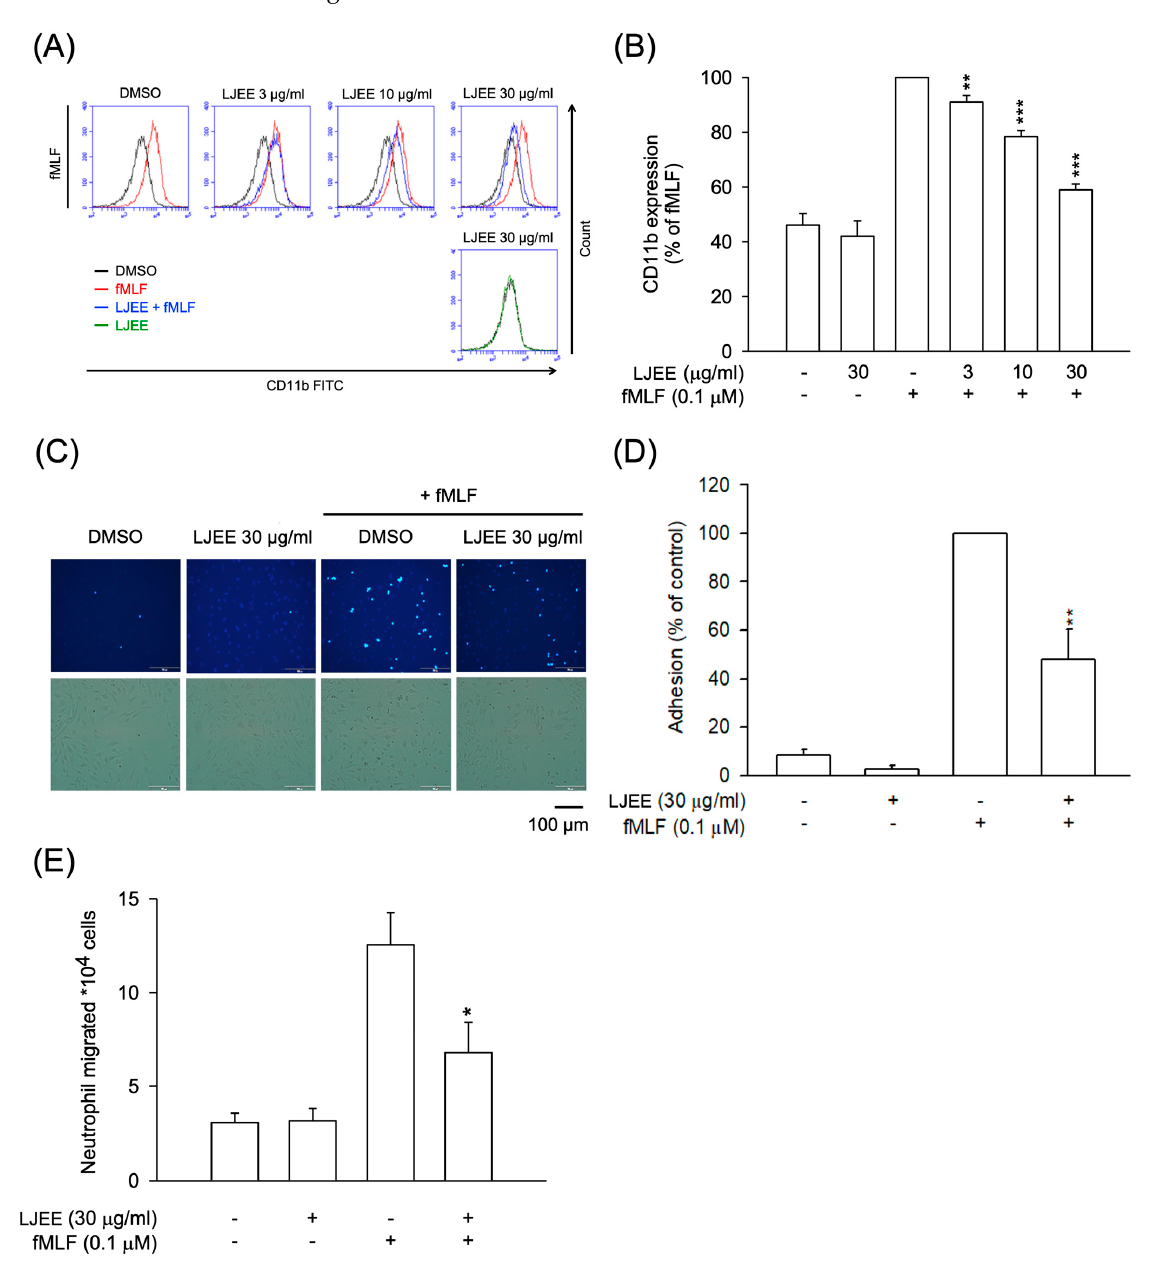
Figure 2. LJEE inhibited CD11b expression, as well as chemotactic migration and adhesion in fMLF- induced human neutrophils. ( A ) A flow cytometry, using Fluorescein isothiocyanate (FITC)-labeled anti-CD11b antibodies, was used to detect the level of CD11b on the cell surface. Mean fluorescence intensities are shown in ( B ). Fluorescent microscopy was used to assess the adherent neutrophils. ( C ) Representative fluorescence (upper panel) and bright (lower panel) field microscopic images. ( D ) Adherent neutrophils were counted and quantified. ( E ) The migrated neutrophils in response to fMLF were determined by cell counter. All the above data are shown as the mean ± S.E.M. ( n = 5–6). * p < 0.05, ** p < 0.01, and *** p < 0.001, compared with the DMSO + fMLF